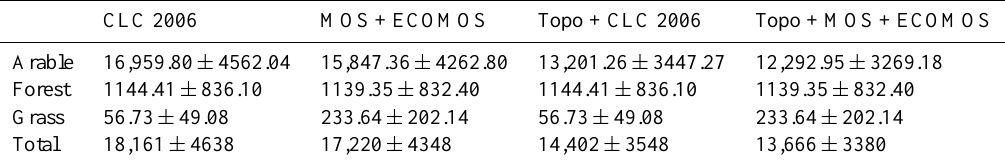
Table 3. N 2 O emission estimations for the Orgeval basin by main land use type and calculated by each upscaling method (in kgN 2 O-N